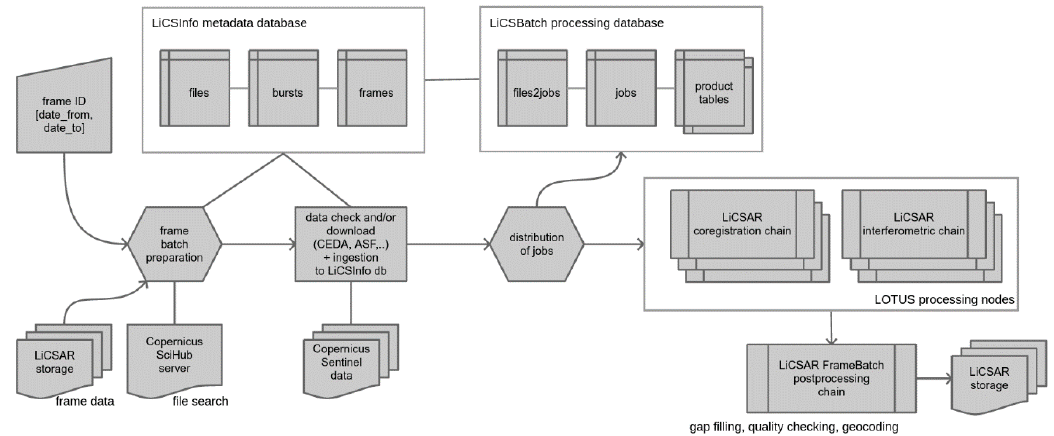
Figure 5. LiCSAR FrameBatch processing chain flowchart—automatic generation of interferometric products for given frame and date limits.